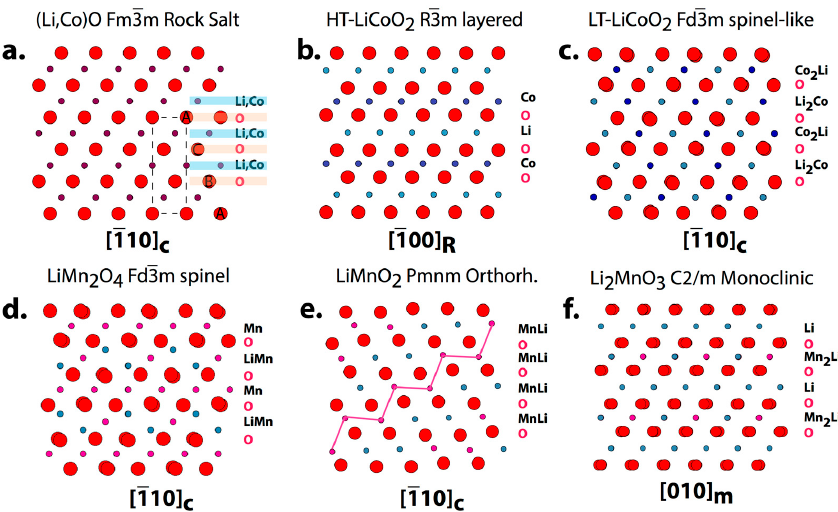
Figure 1. Structural projections along the crystallographic direction corresponding to (cid:4670) 1 (cid:3364) 10 (cid:4671) c of the (pseudo)-cubic oxygen sublattice and revealing its ABCABC… stacking sequence for ( a ) (Li,Co)O cubic rock-salt type; ( b ) high-temperature rhombohedral HT-LiCoO 2 ; ( c ) low-temperature